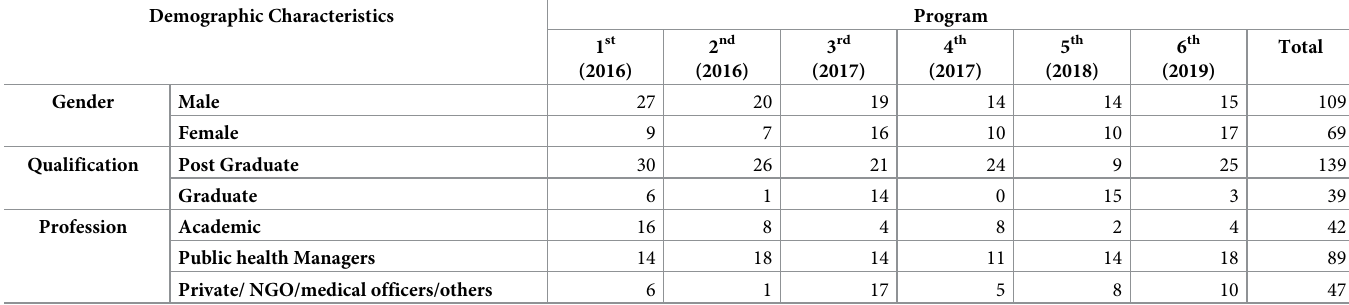
Table 1. Distribution of participants of International Public Health Management Development Programs (2016–2019).